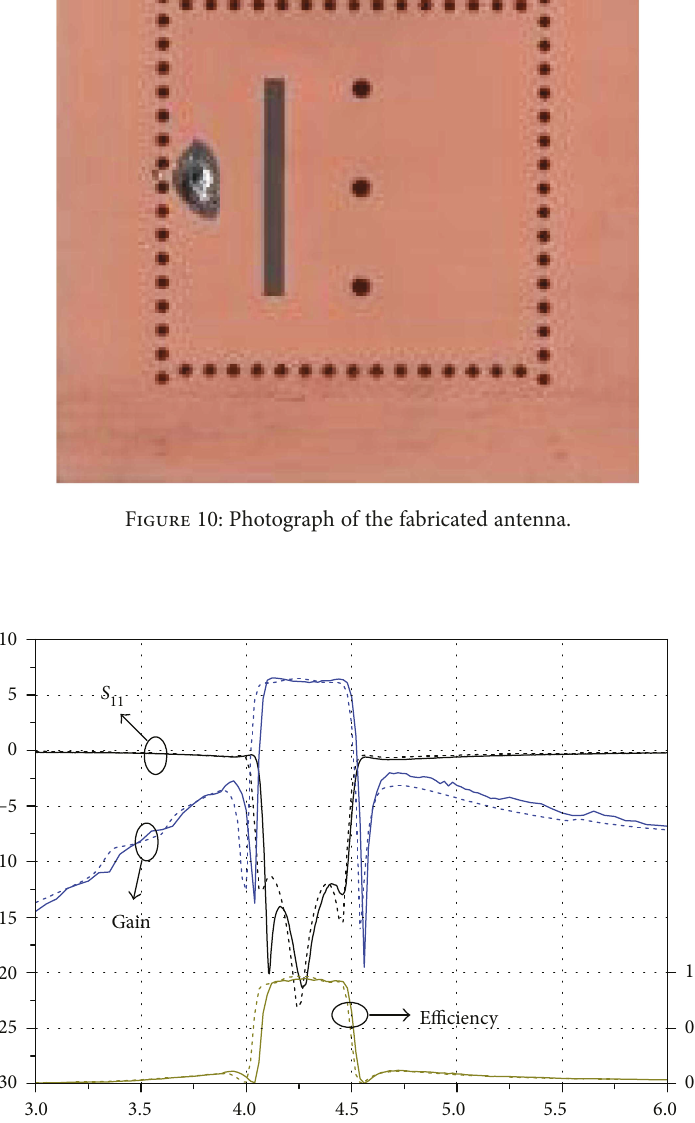
, realized gains, and total e ffi ciencies. 11